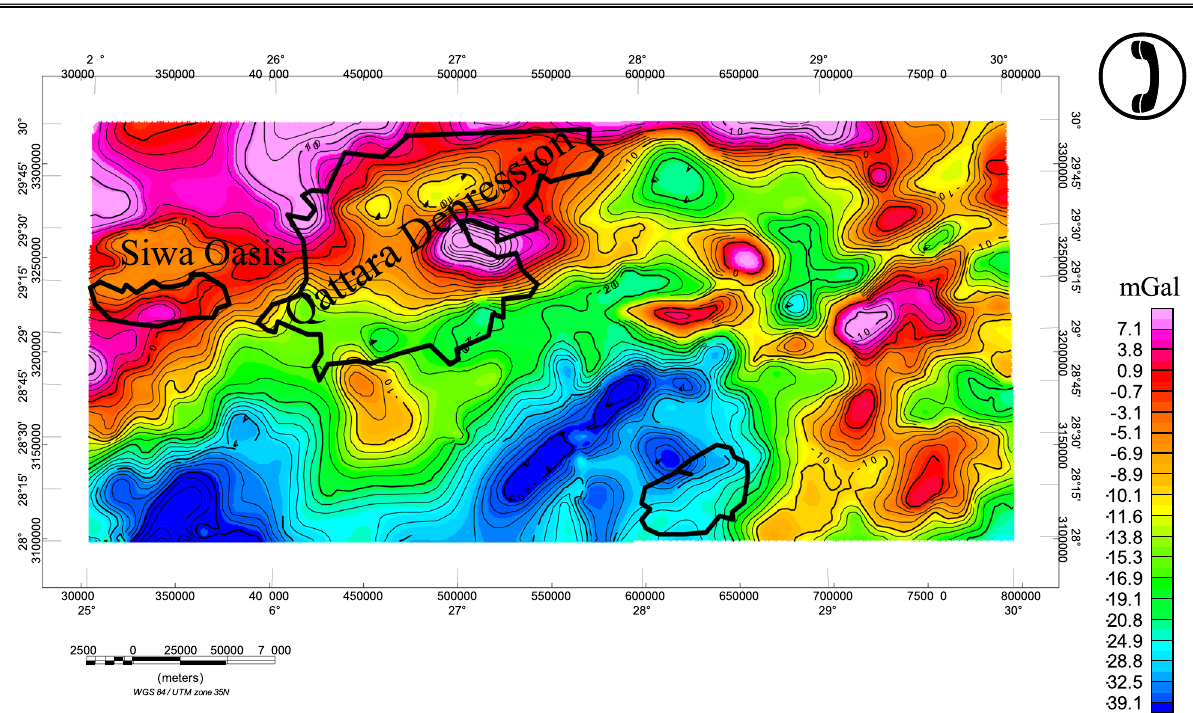
Figure 5: Bouguer gravity anomaly map in the study